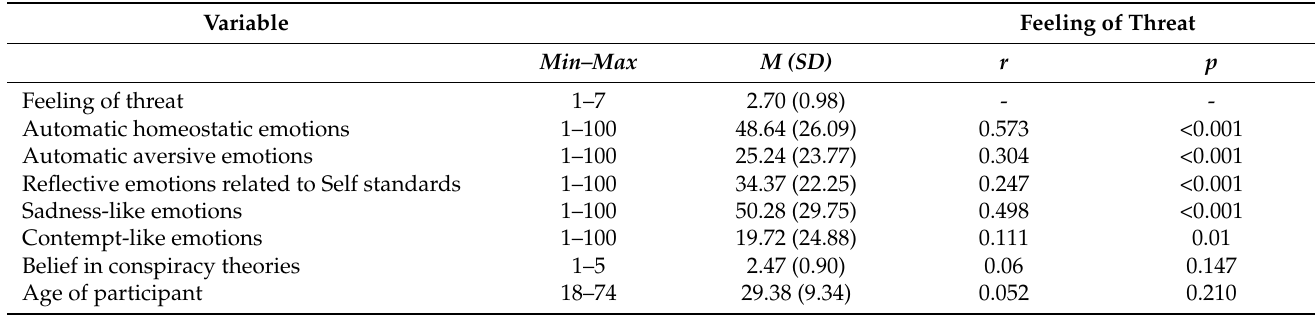
Table 1. Correlates of the feeling of threat caused by the COVID-19 pandemic ( N = 575). The table presents Min–Max values, Means and Standard Deviations for all the variables, as well as values of Pearson’s r correlations and statistical significance. Sadness-like and contempt-like emotions are reflective emotions not related to Self